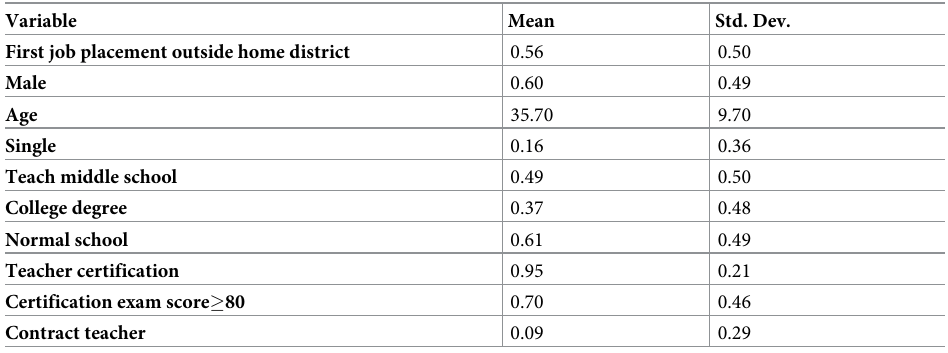
Table 3. Descriptive statistics of teacher-level